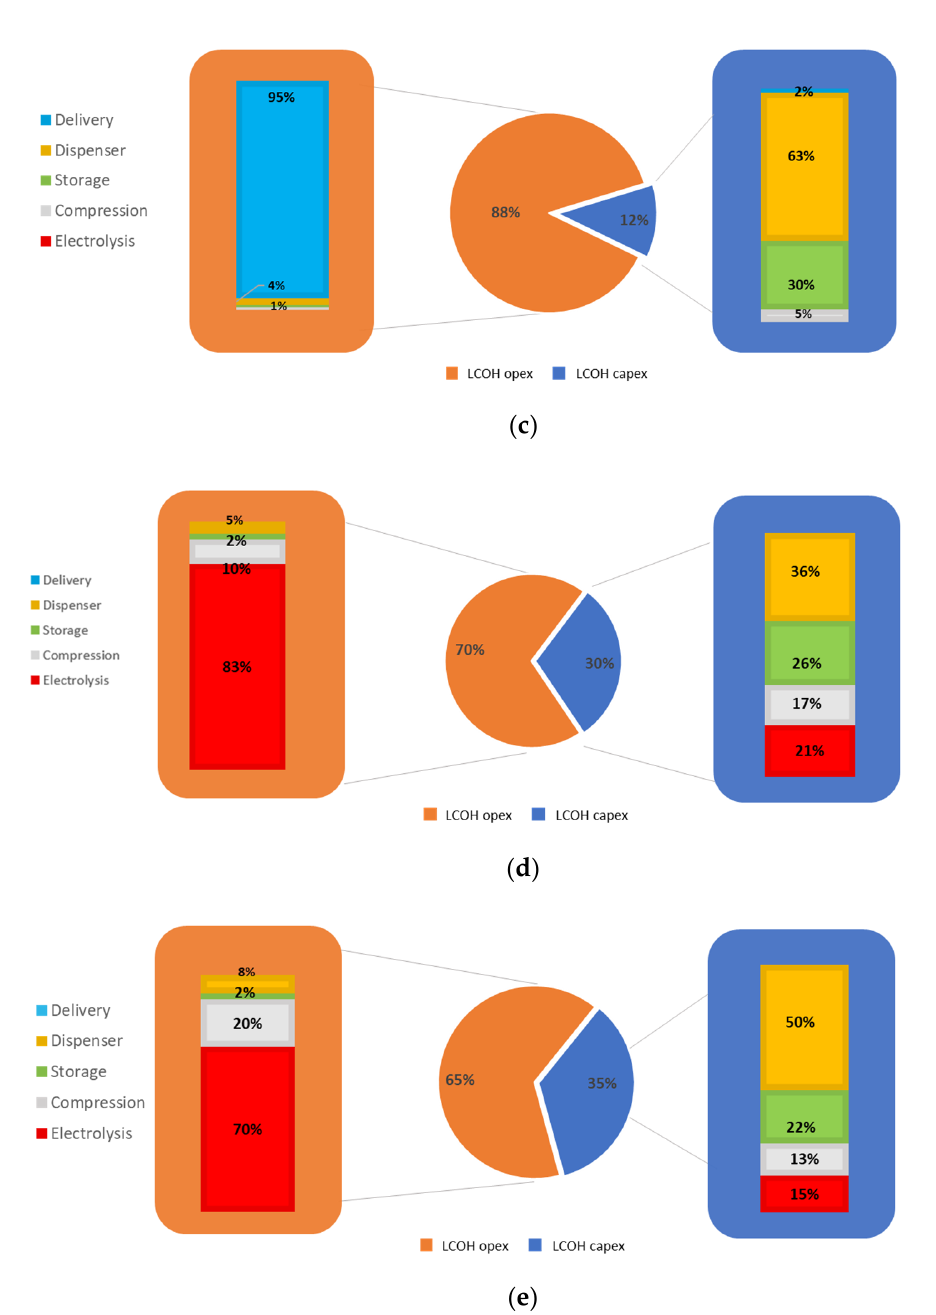
Figure 2. ( a ) London HRS cost breakdown; ( b ) Rotterdam HRS cost breakdown; ( c ) Versailles HRS cost breakdown; ( d ) Aalborg HRS cost breakdown; ( e ) Pau HRS cost breakdown. Table 5. HRS parameters considered for dispenser numbers . Table 6. Cost model results in terms of CAPEX, OPEX, and LCOH for all the